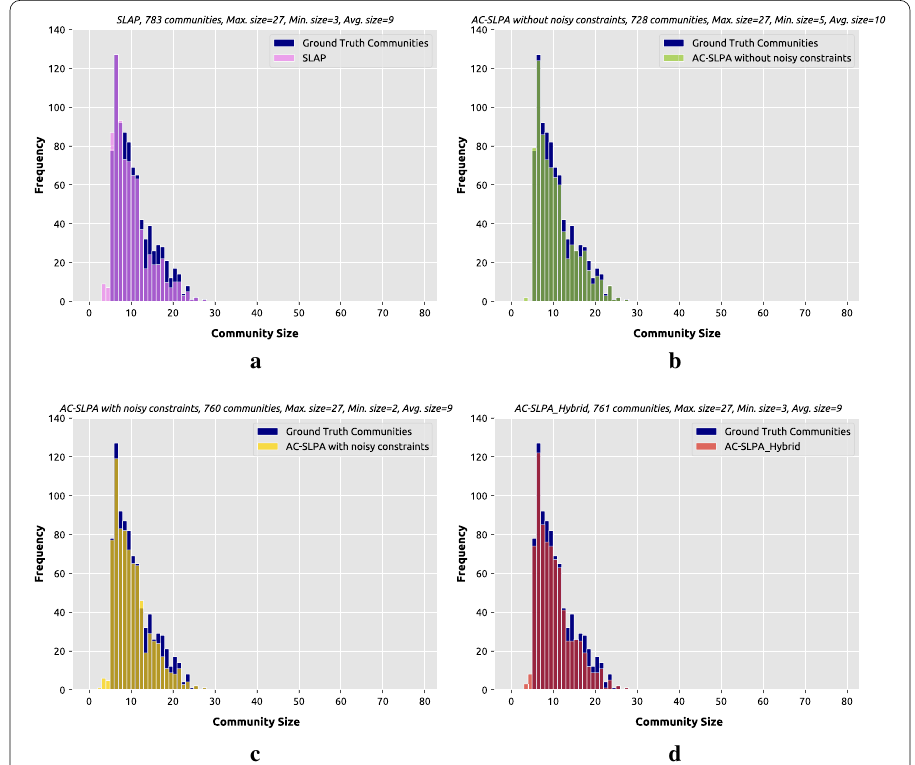
Fig. 14 Community size distribution for communities produced by SLPA, AC-SLPA with noisy pairwise constraints, and AC-SLPA with Hybrid cleaning on the Amazon network, compared to the ground truth community size